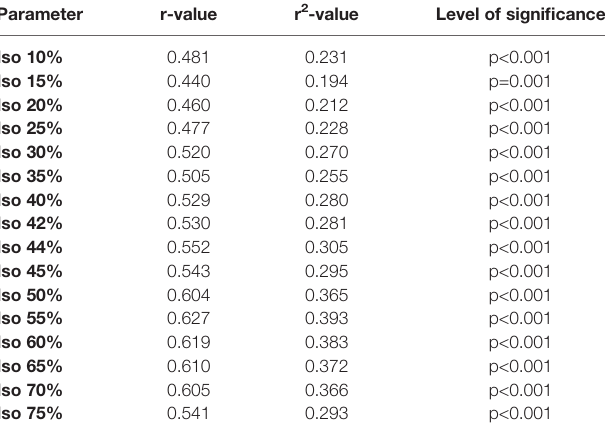
TABLE 2 | Isocontour volumetric correlation. Parameter